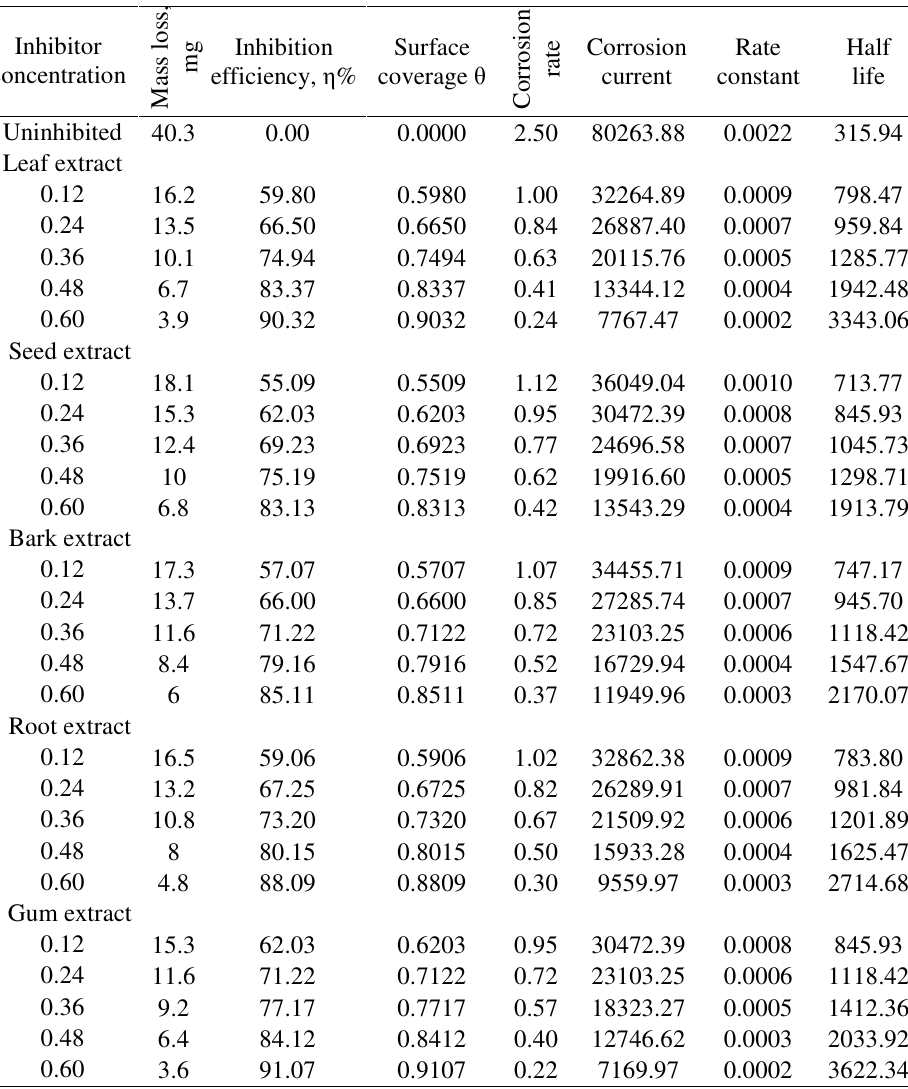
Table 1. Effect of extract of different parts of plants Acacia Senegal on mass loss data